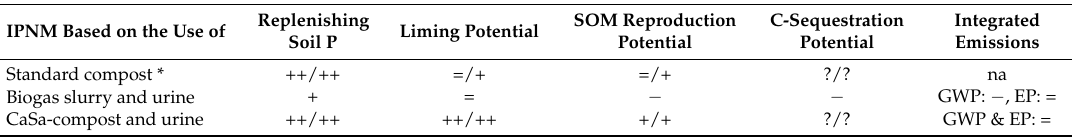
Table 5. Summarized effects estimated for the IPNM strategies analyzed with regard to selected sustainability